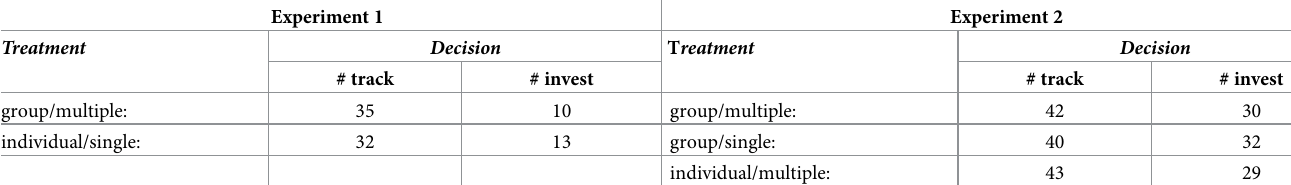
Table 3. Subject portfolio decisions in the experiments.